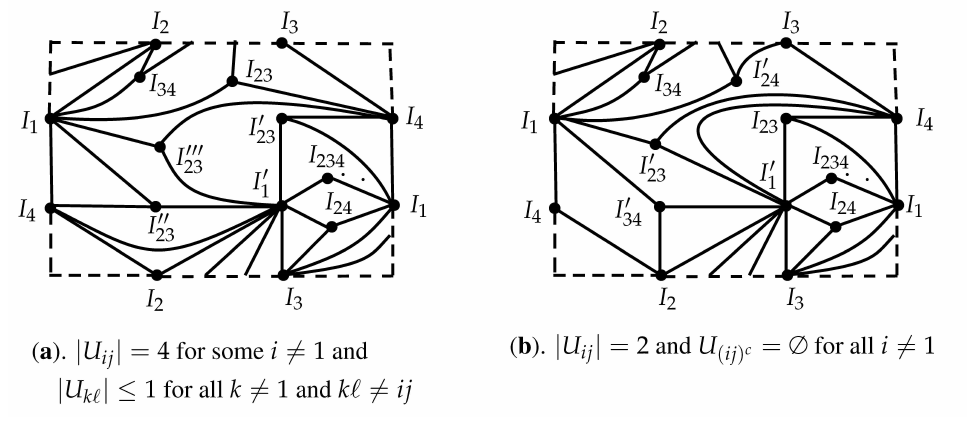
∪ 4 U n | = 5 with | U 1 | = n = 1